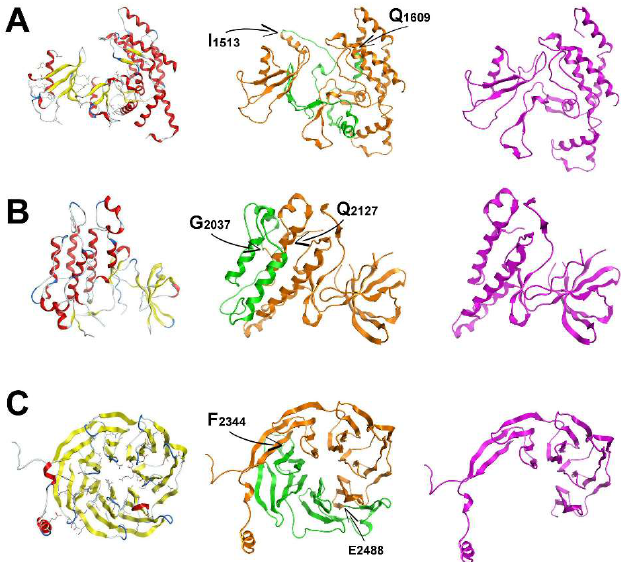
Figure 3. A molecular modelling study of the COR, KIN and WD40 domains of LRRK2 ( A , B , and C respectively). In the left column is the full 3D homology model of each one of the three aforementioned domains of LRRK2. They are shown in ribbon representation and are color-coded by secondary elements, where α-helices are red spirals, β-sheets are yellow arrows and loops are white coils. The middle column depicts the same three 3D homology models as in the left column. Models have also been rendered in ribbon representation, only this time they have been colored based on their corresponding splicing events. The orange color is the full model, whereas in the green ribbon is the part of the structure that is absent in the spliced form. The start and end points of each splicing event have been highlighted on the 3D structure of the three models. Finally, the third column contains the spliced 3D models of ROC, COR and WD40, and is shown in purple ribbon representation. Note that in the case of COR, the spliced 3D model had to be stitched together as it is a mid-segment of the structure that is spliced, whereas in the cases of KIN and WD40 the part of the structure was removed, and the spliced structures were in silico energetically re-optimized.